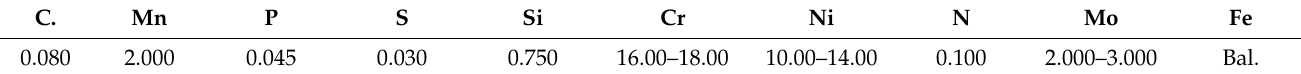
Figure 1. The image of experimental equipment and rotary friction welded SS 316-pure Zn. Table 1. Chemical composition of 316 stainless steel (wt.%).